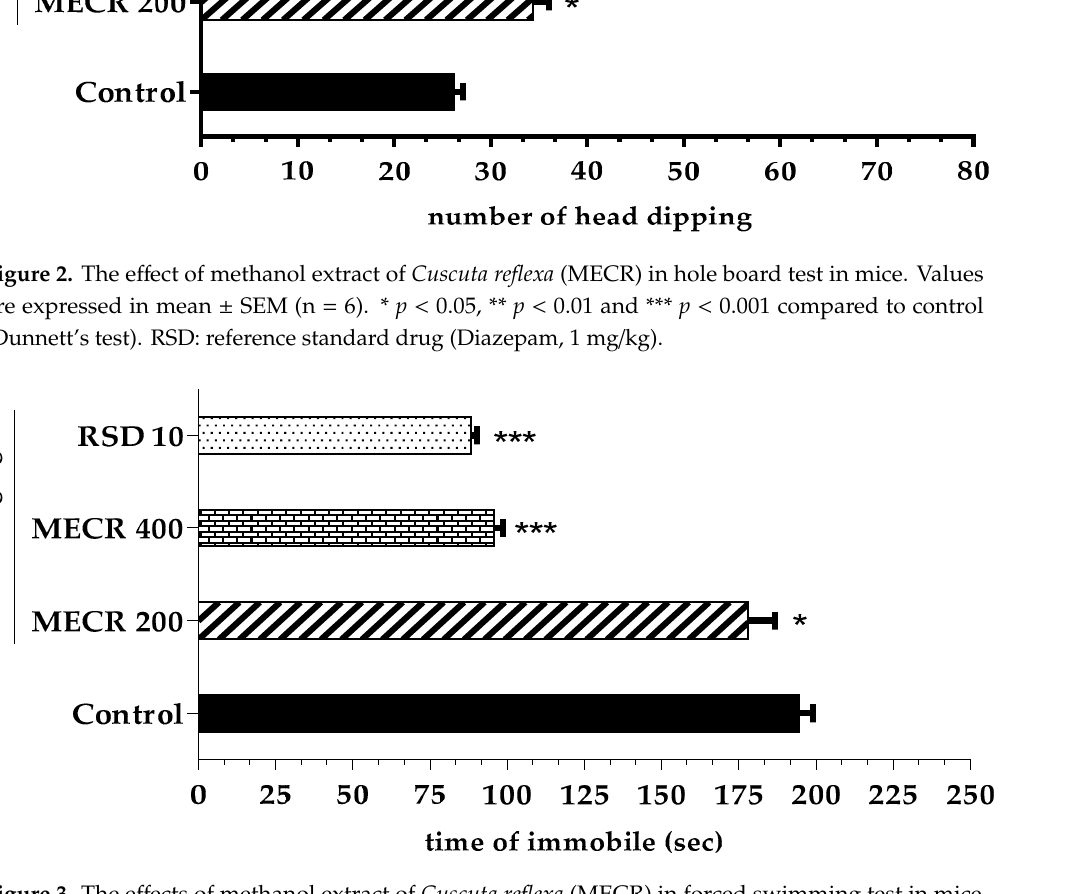
Figure 2. The effect of methanol extract of Cuscuta reflexa (MECR) in hole board test in mice. Values are expressed in mean ± SEM (n = 6). *p < 0.05, **p < 0.01 and ***p < 0.001 compared to control (Dunnett’s test). RSD: reference standard drug (Diazepam, 1 mg/kg).